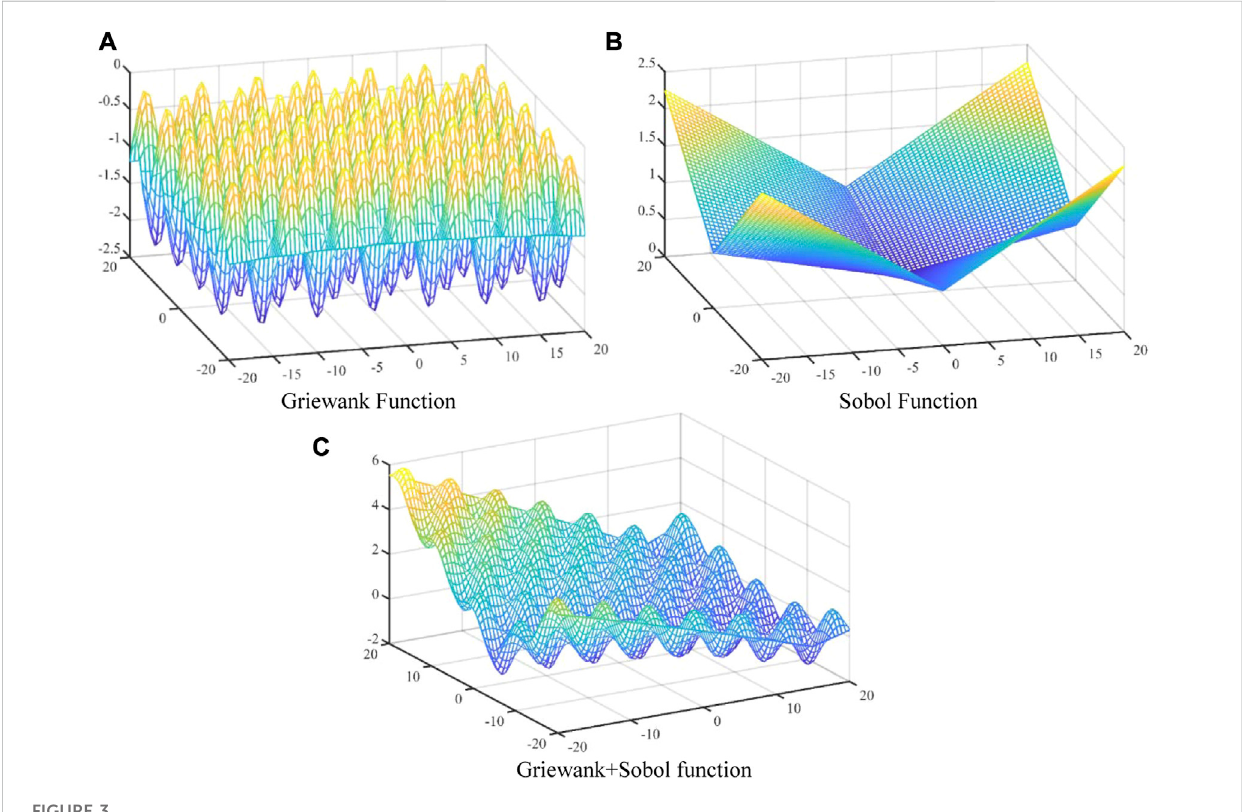
FIGURE 3 Graphs of benchmark